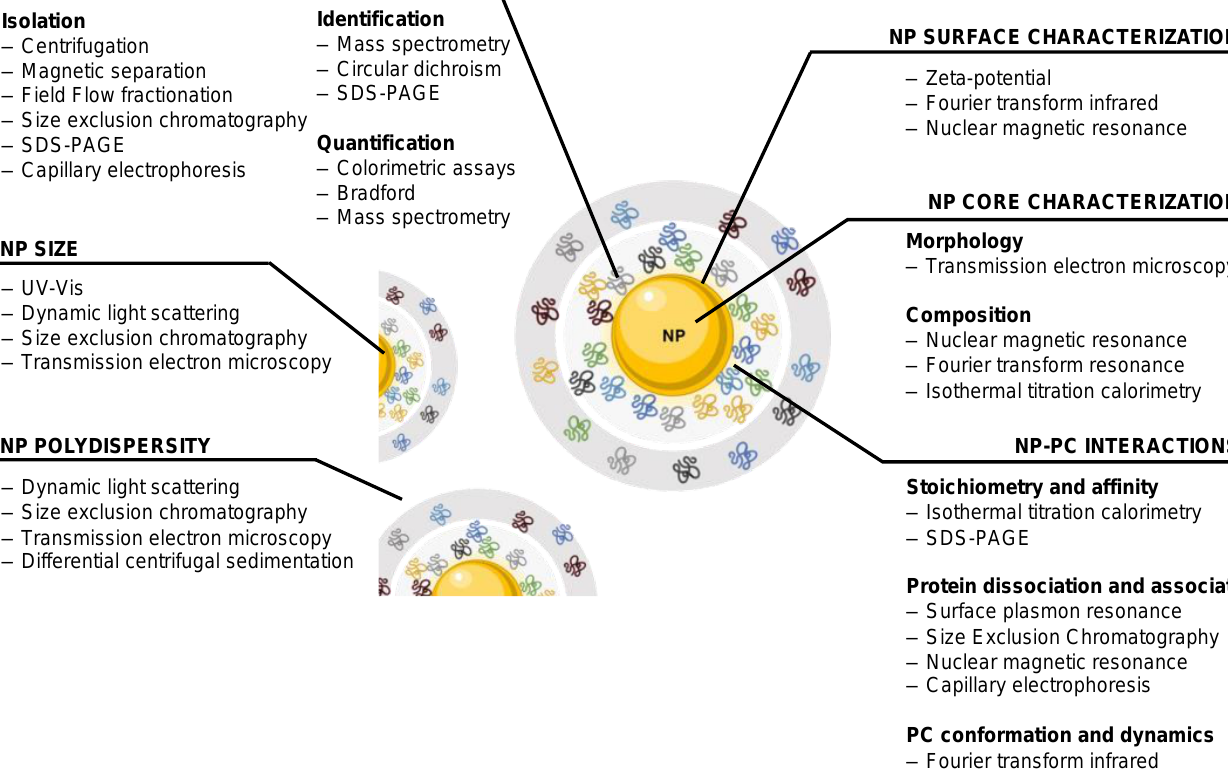
Figure 2. Common methods used to characterize nanoparticle–protein corona complexes.